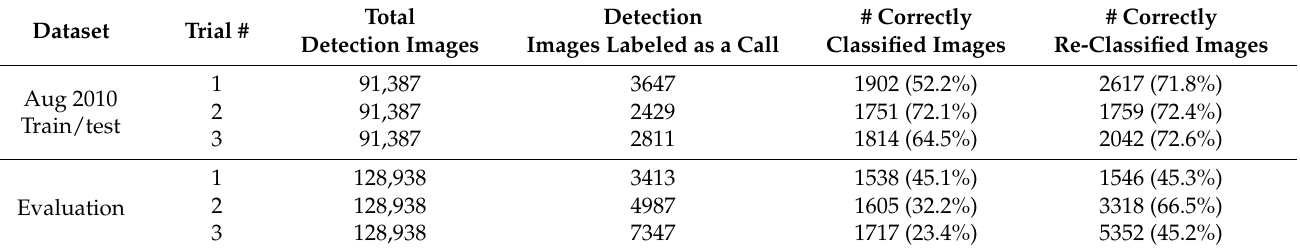
Table 4. Reclassification statistics including the total number of detection images, the number of detection images labeled as a fish call, the number (and percentage) of correctly classified detection images, and the number (and percentage) of correctly re-classified detection images for the three trials for each